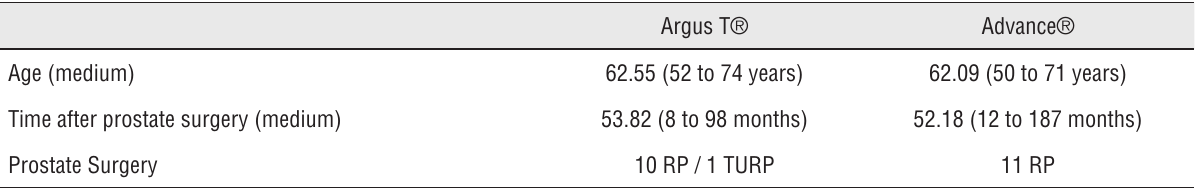
Table 1 – Time after prostate surgery, age and type of SSU surgery.